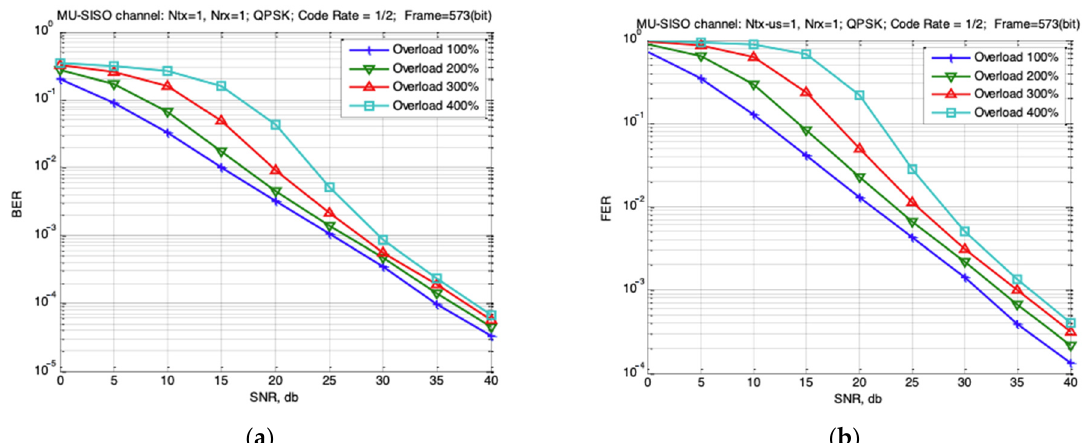
Figure 4. Dependencies of ( a ) BER and ( b ) FER for MU-SISO uplink systems with FEC from SNR for different number of users (different degree of loading).